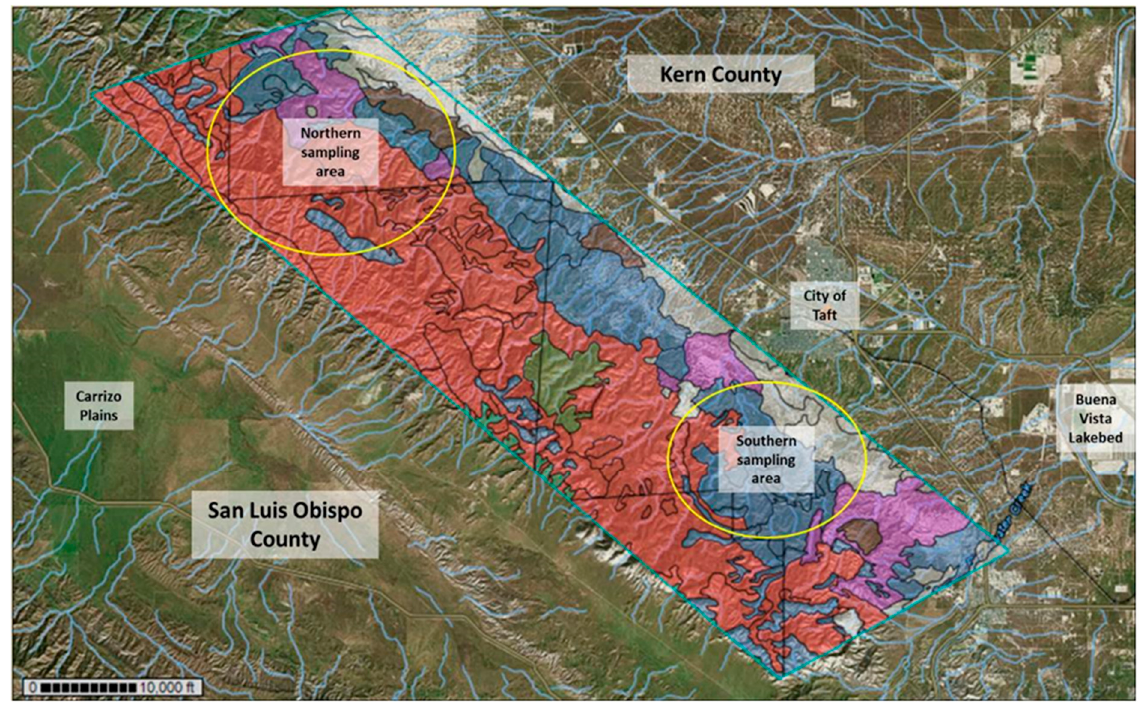
Figure 1. Map of the Temblor SRMA extending over parts of Kern County and San Luis Obispo County, CA, (county border seen as black zigzag line) with indication of the northern and southern sampling areas (yellow circles). Different soil types are indicated in distinct colors based on information from the USDA WSS database (Beam–Panoza–Hillbrick complex (red), Pyxo–Cochora–Badlands association (dark blue), Xeric Torriorthents–Badlands (light blue), Littlesignal–Cochora association (magenta), Reward channery loam (kaki), Elkhills–Welport association (grey), Elkhills–Pyxo association (brown), Padres sandy loam (green). Soils of some less abundant soil types, e.g., soils of the Xerorthents–Badlands association, are not seen in this overview.